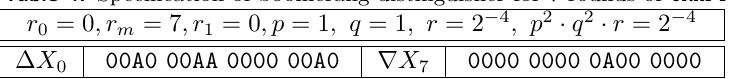
Table 4: Specification of boomerang distinguisher for 7 rounds of